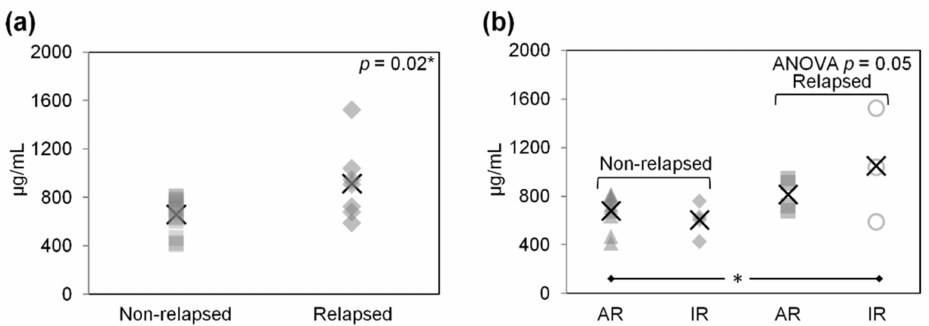
Figure 4. Abundance of clusterin (CLU) ( µ g/mL) in non-relapsed and relapsed pediatric/adolescent HL patients, measured using Luminex-based assays (validation phase). In ( b ), the non-relapsed and relapsed patients shown in ( a ) are divided according to their adequate (AR) or inadequate (IR) response to therapy on early response assessment, as explained in the Materials and Methods. In ( b ), ANOVA p -values are given in the top right-hand corner of the graph. Symbols identify individual patients, and crosses indicate mean values. * significance for p -value < 0.05, Student’s t